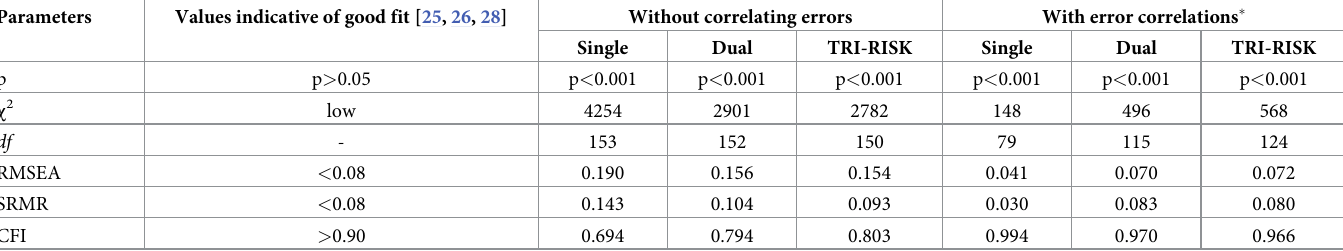
( � ) 74 error correlations were entered for the single factor model and 37 for the dual model. For the TRIRISK model, 26 correlations were entered, having excluded one correlation in the affective category due to low error variance resulting in non-convergence. S1 Table 1 in S1 File shows the fit parameters for immediate follow-up to allow comparison with the baseline data shown